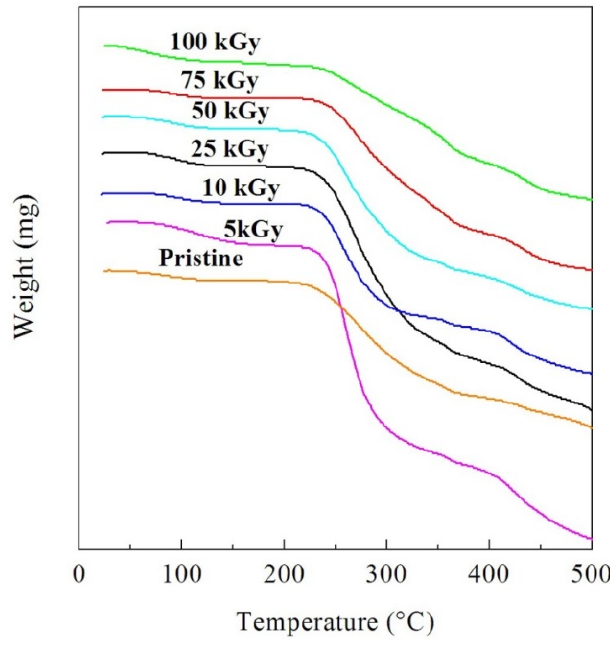
Figure 4. TGA curves of the pristine and γ irradiated NC films. Table 1. Degradation temperatures (T o , T 1 ), activation energies of thermal decomposition (E a1 , E a2 ) of the two weight loss steps and melting temperature (T m ) of the PVA-Lg/Pd NC films versus γ dose.